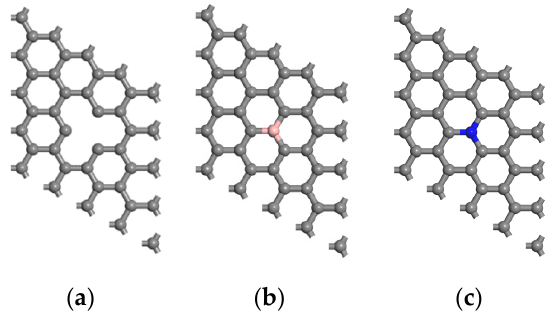
Figure 1. Physical models of graphene: ( a ) Vacancy defect graphene (VG); ( b ) B-doped graphene; ( c ) N-doped graphene.